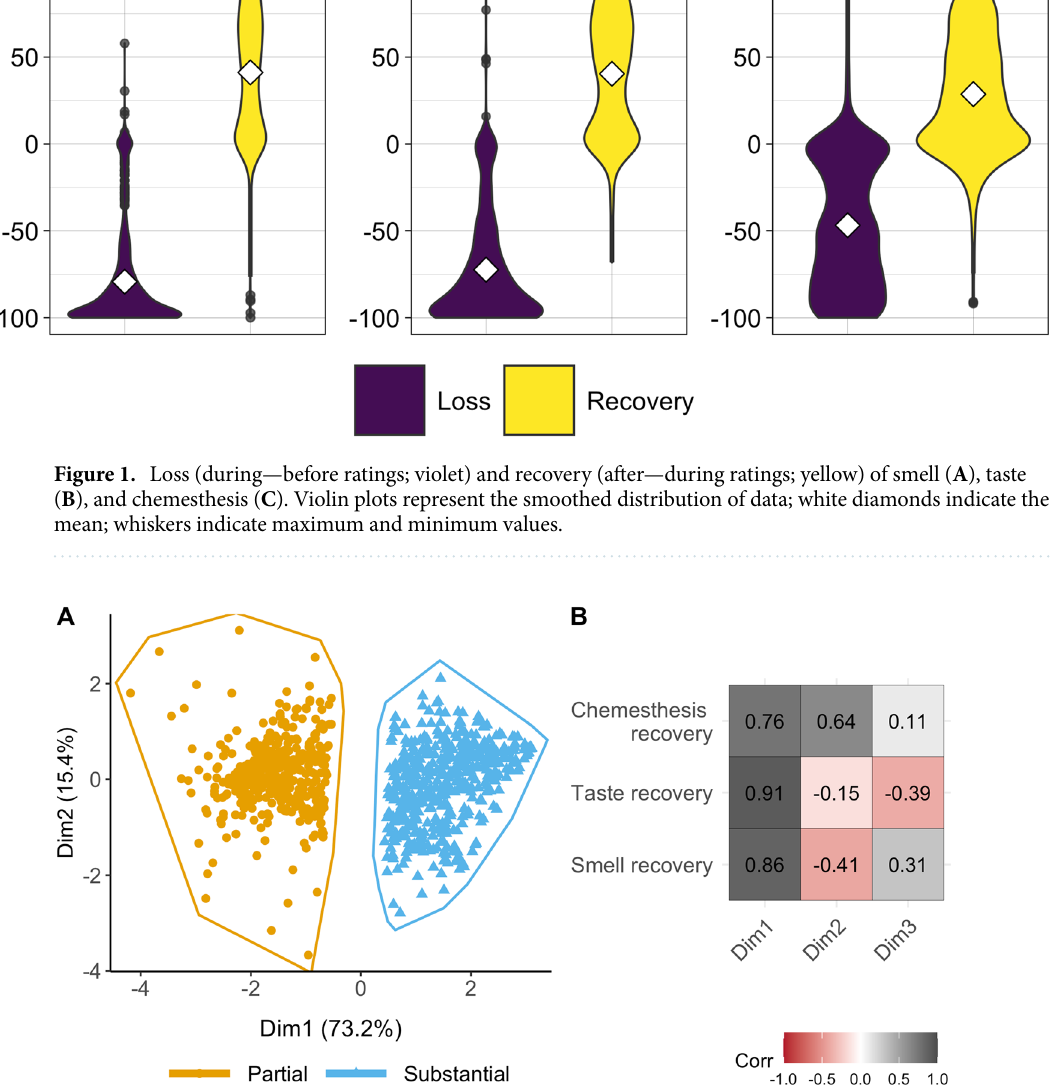
Figure 2. ( A ) Clusters of participants on chemosensory recovery identified by k-means clustering. The scatterplot shows each participant’s loading on Dimension 1 (Dim1) and Dimension 2 (Dim2) of the Principal Component Analysis. Partial = smell, taste, and chemesthesis partial recovery; Substantial = smell, taste, and chemesthesis substantial recovery. ( B ) Correlations between the three principal components with respect to recovery in smell, taste, and chemesthesis. Gray color indicates a positive correlation, whereas shades of red indicate negative correlations. Darker shades indicate stronger